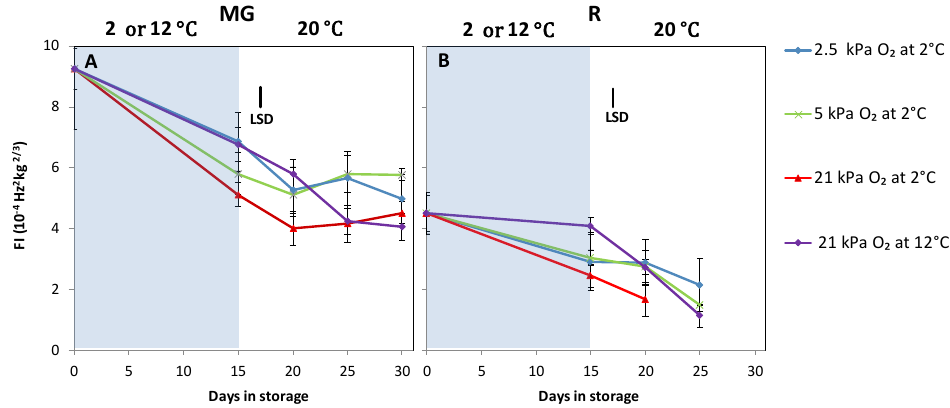
Figure 3. Firmness index of MG ( A ) and R ( B ) tomatoes during cold storage at 2 or 12 °C (blue area) and subsequent shelf-life at 20 °C (white area). Blue, green, red and purple lines and symbols indicate 2.5, 5, 21 kPa O 2 (low oxygen control) applied during storage at 2 °C and 21 kPa O 2 at 12 °C (temperature control), respectively. The average firmness index with indicated standard error is shown for five tomatoes. LSD values ( p < 0.05) are indicated per panel.